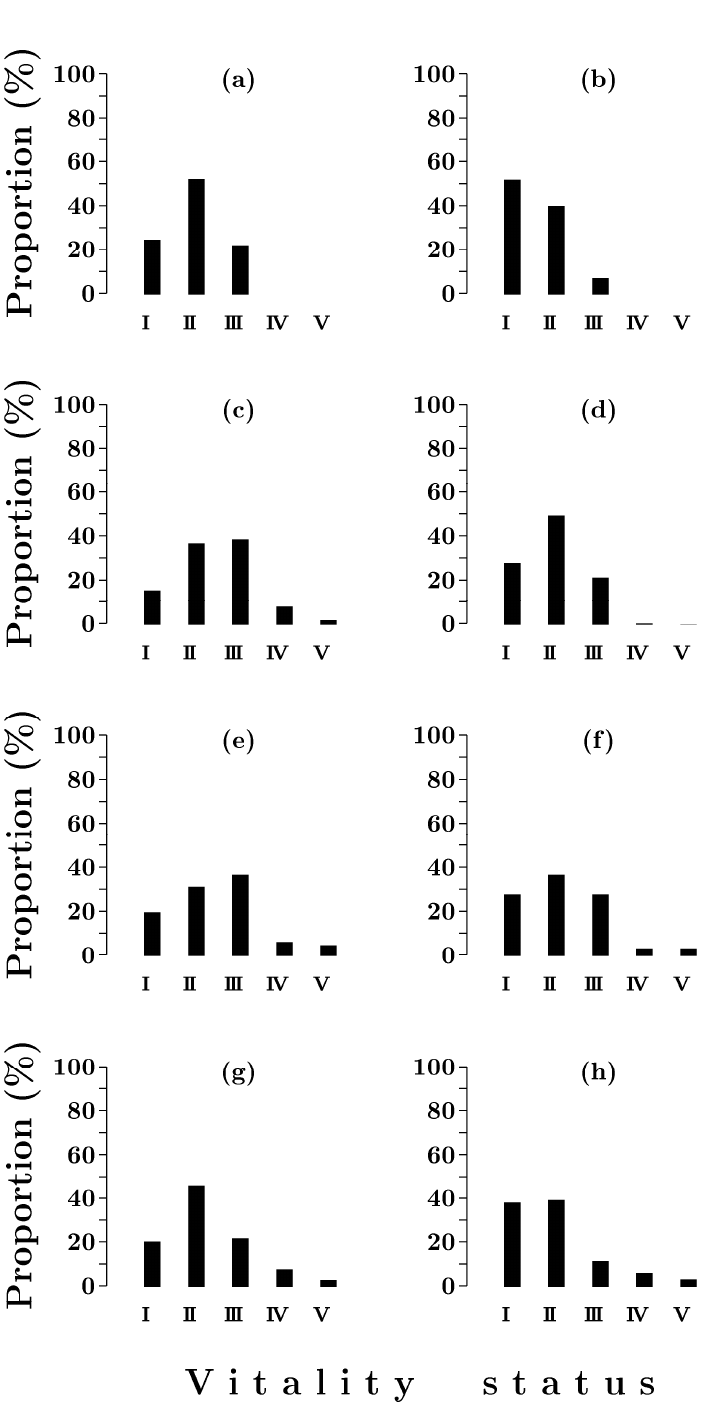
Figure 4. Vitality class distributions of Picea obovata stands in Siberian spruce forests with post-fire periods of 80 ( a , b ), 150( c , d ), 220 ( e , f ) and 380 ( g , h ) years. I–V—vitality status: I—healthy trees; II—moderately weakened trees; III—strongly weakened trees; IV—dying trees; V—dry trees. a, c, e, g—by number of individuals; b, d, f, h—by